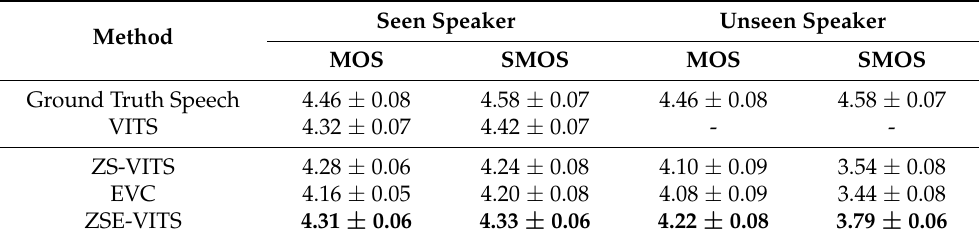
Table 3. MOS and SMOS scores of different